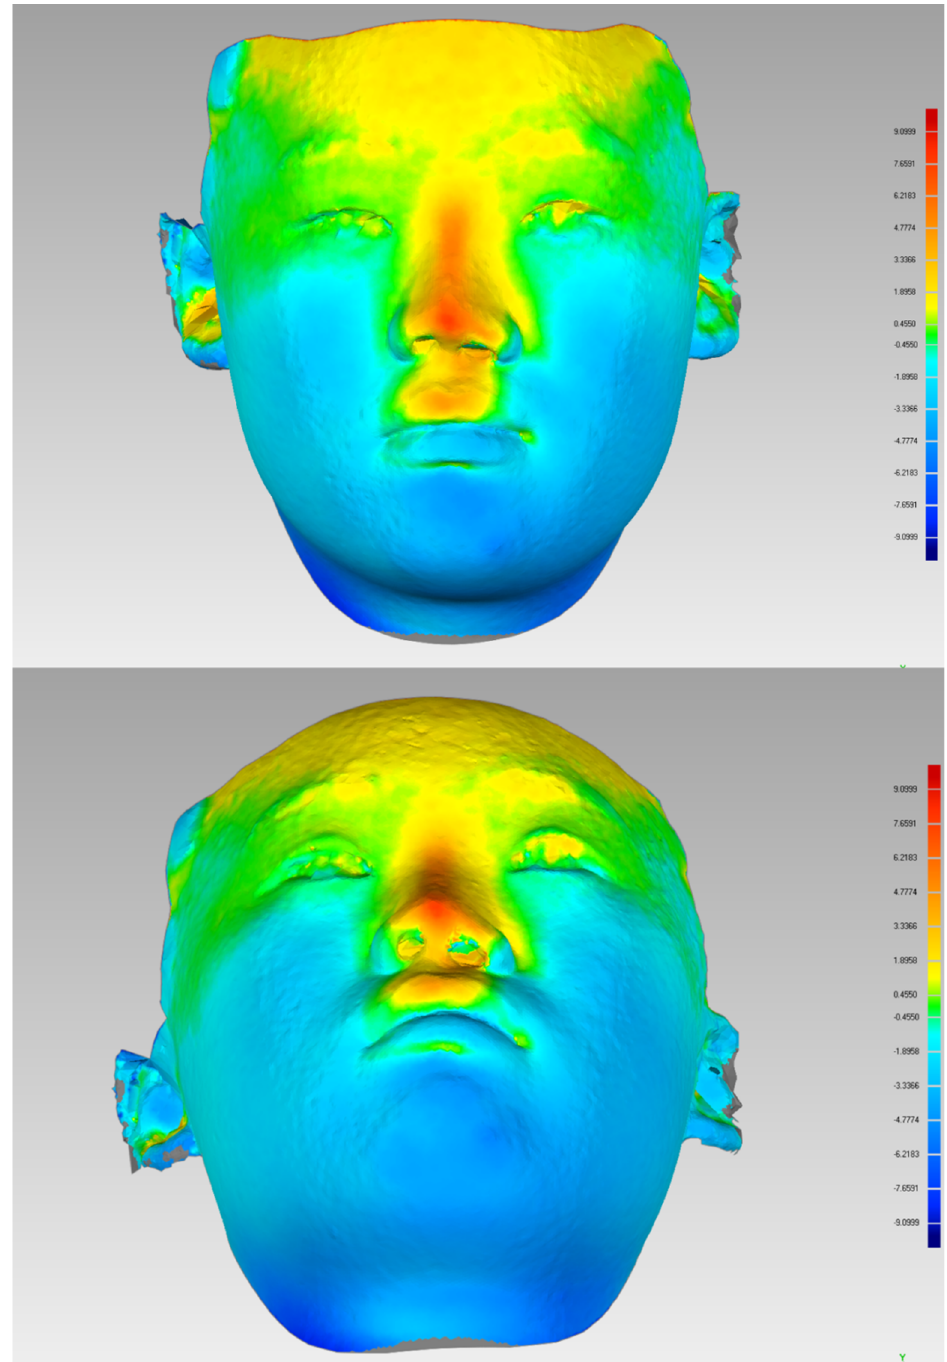
Figure 3. Three dimensional photographs were taken by three-dimensional photogrammetric camera (3dMDFaceTM System, 3dMD, USA) with a standardized protocol. Import images into Geomagic wrap software (Geomagic Wrap 2015, 3D Systems, USA) for thermographic analysis. Comparing the images before and after the operation after alignment registration, the patient’s nasal tip and nasal back changed greatly compared with that before the operation.